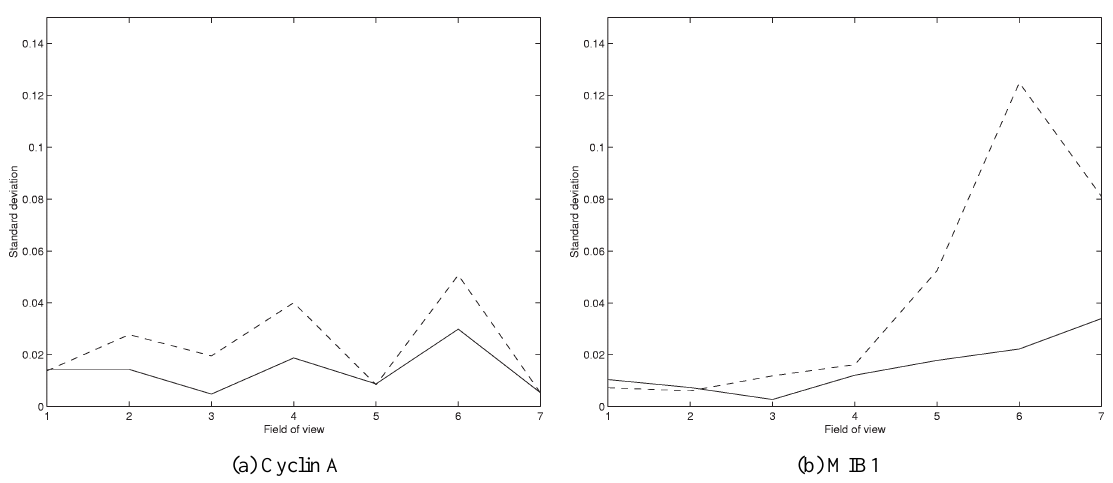
Fig. 12. The line shows standard deviations for each field of view using the method with controls and the dashed line shows standard deviations for each field of view using the automatic method without controls. The method with controls shows low variation (the average standard deviation was 1.5%) for all images, whereas the method without controls shows somewhat higher variation (the average standard deviation in this case was 3.3%), but the variations are still to be regarded as low for most images.